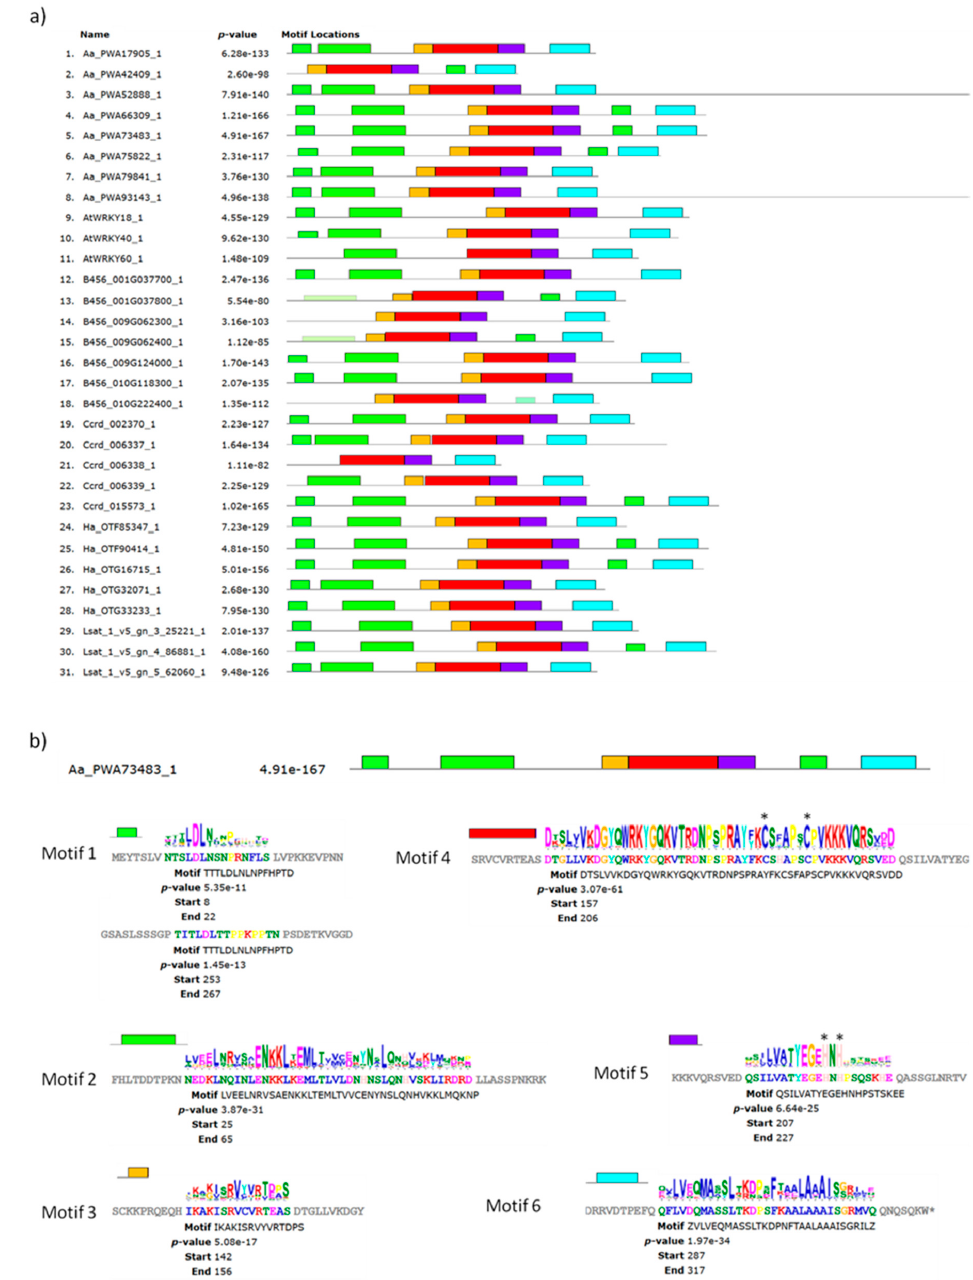
Figure 7. Results of the MEME analysis run on the 31 group IIa WRKY proteins from A. annua (Aa), L. sativa (Lsat), C. cardunculus (Ccrd), H. annuus (Ha), A. thaliana (At) and G. raimondii (B456), visualization of the six identified conserved domains with different colors (Motif 1, green; Motif 2, light green; Motif 3, orange; Motif 4, red; Motif 5, indigo; Motif 6, light blue) ( a ). Motifs and consensus sequences found in the AaWRKY40 (Aa_PWA73483_1) protein ( b ). Asterisks mark the invariant cysteines and histidines that are required to form the zinc-finger motif located in Motif 4 and 5.